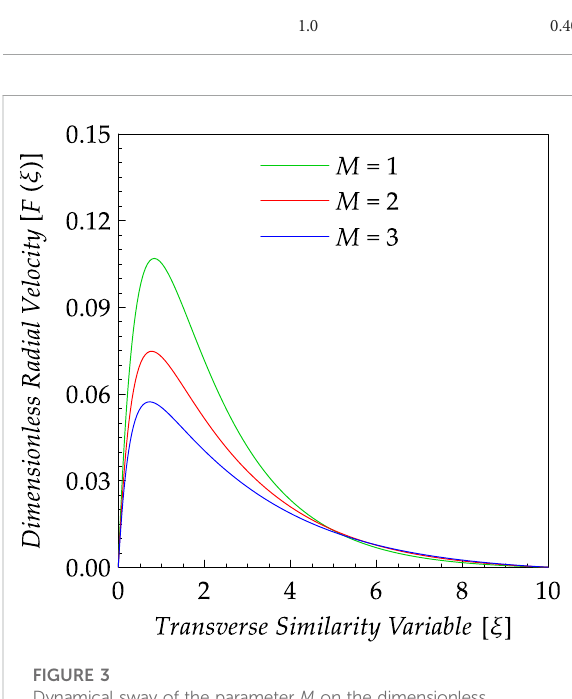
FIGURE 3 Dynamical sway of the parameter M on the dimensionless velocity F ( ξ ) .